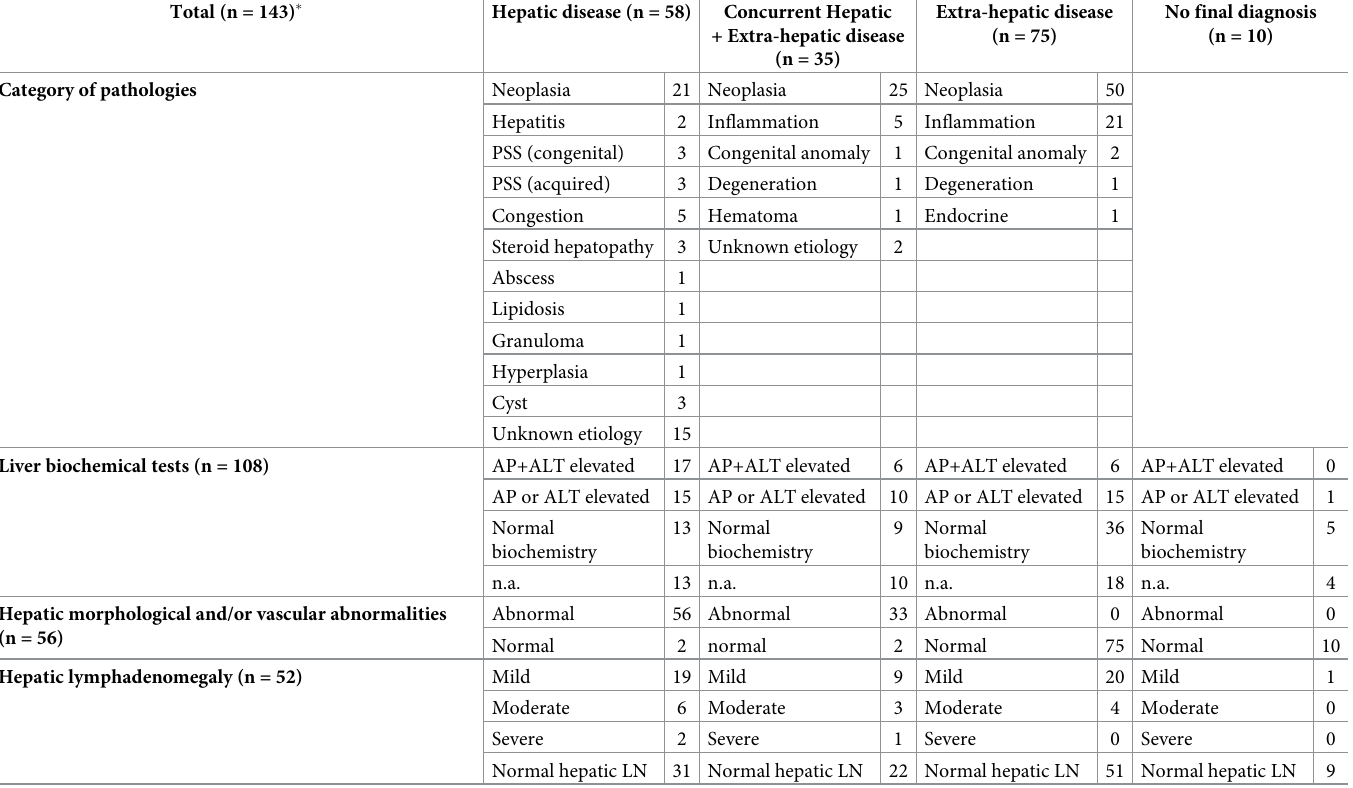
Table 1. Summary of patient data sorted by hepatic, concurrent hepatic + extra-hepatic, extra-hepatic disease and no final diagnosis. Total (n = 143)